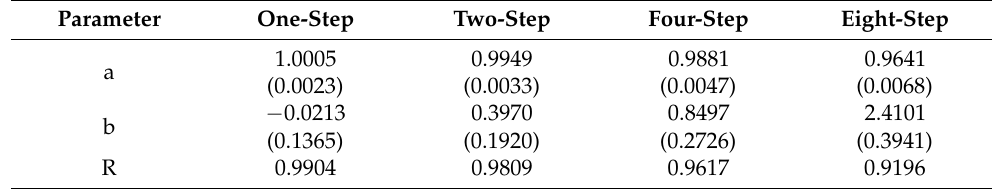
Table 1. Linear regression parameters of different prediction horizons of the WT-FNN